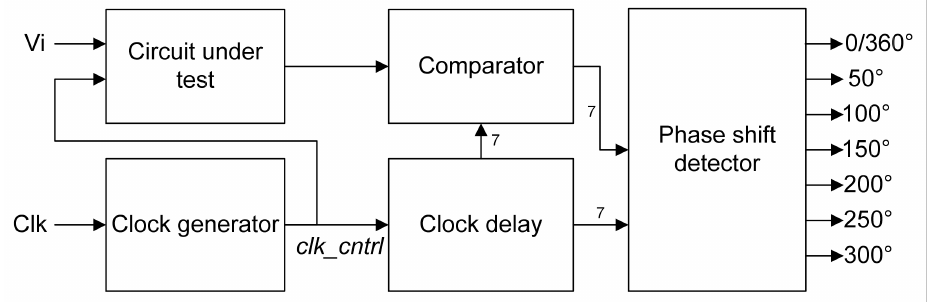
Figure 3. The schematic diagram for an aging sensor